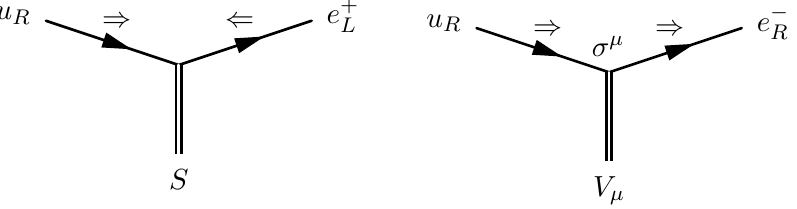
(cid:30) eu = 1 TeV and (cid:21) (cid:30) eu = 1.